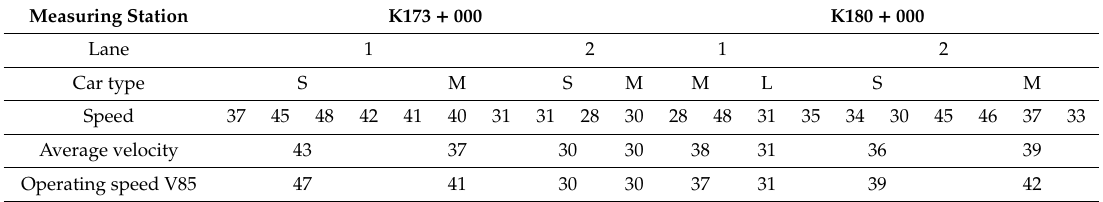
Table 4. Summary of speed measurement at each intersection (km / h).